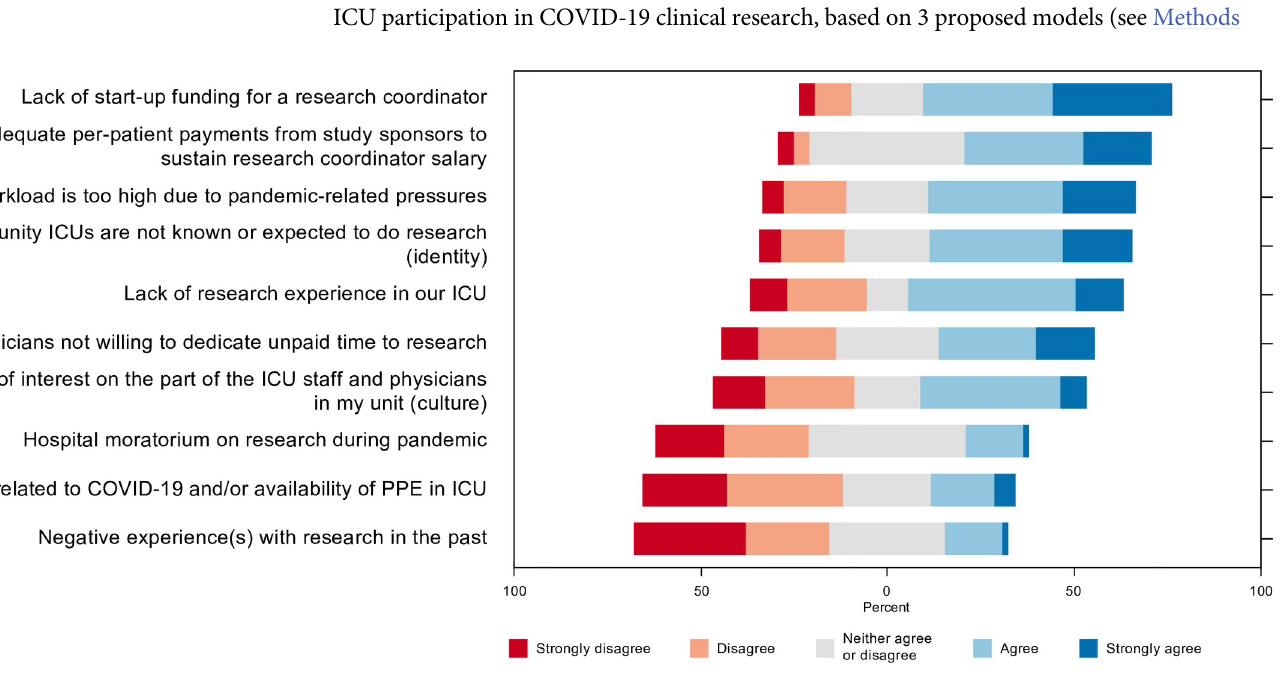
Fig 5. Barriers to community ICU research